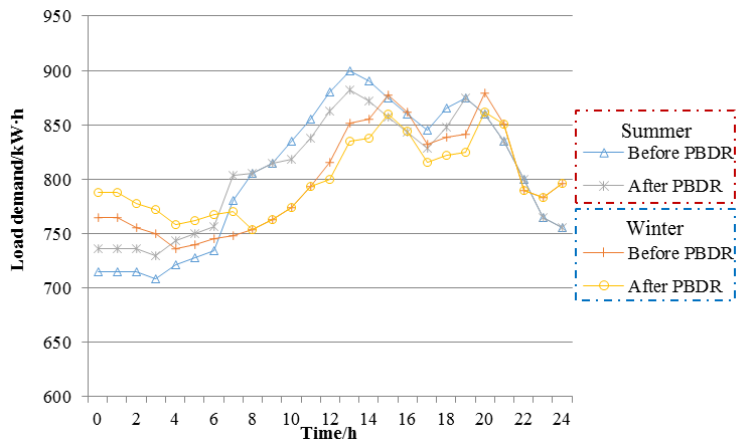
Figure 13. Load demand of terminal customers in typical day before/after PBDR.